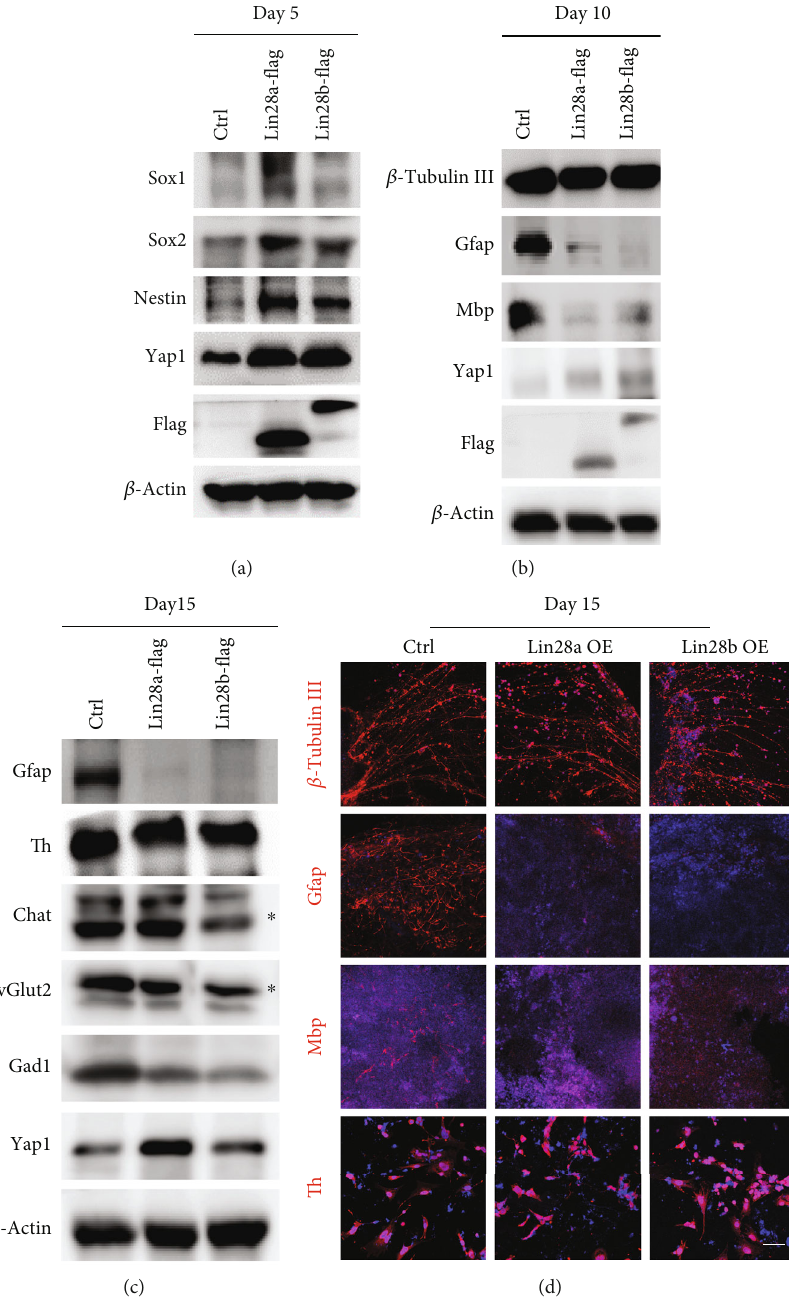
Figure 3: Constitutive overexpression of Lin28a/b inhibited the di ff erentiation of mouse ESCs to glial lineage cells. (a) Western blot analyses of total proteins from Ctrl and Lin28a/b OE mouse ESC di ff erentiated cells on day 5 using the indicated neural stem cell markers: Sox1, Nestin, and Sox2. (b) Western blot analyses of total proteins from Ctrl and Lin28a/b OE mouse ESC di ff erentiated cells on day 10 using the indicated neuronal marker: β -tubulin III, glial markers: Gfap and Mbp. (c) Western blot analyses of total proteins from Ctrl and Lin28a/b OE mouse ESC di ff erentiated cells on day 15 using the indicated neuronal subtype markers: Th, vGlut2, Gad1, and Chat. (d) Immuno fl uorescence staining of the Ctrl and Lin28a/b OE mouse ESC di ff erentiated cells on day 15 using the neuronal marker β -tubulin III and glial markers Gfap and Mbp, and neuronal subtype markers Th. Cell nuclear was stained with DAPI. Scale bar, 200 μ